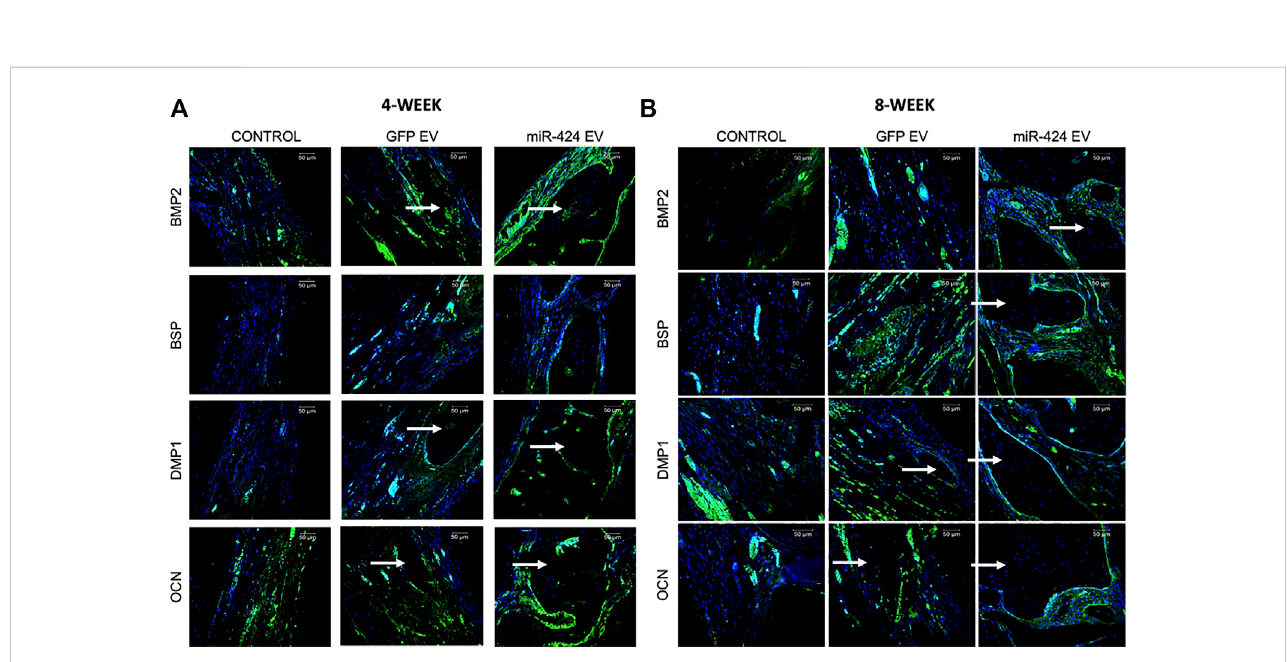
FIGURE 8 Immunohistochemistry of calvarial sections. (A,B) Representative confocal micrographs of calvarial sections from 4 to 8 weeks samples respectively immunostained for BMP2, BSP, DMP1 and OCN proteins. Scale bar represents 50 μ m in all images.